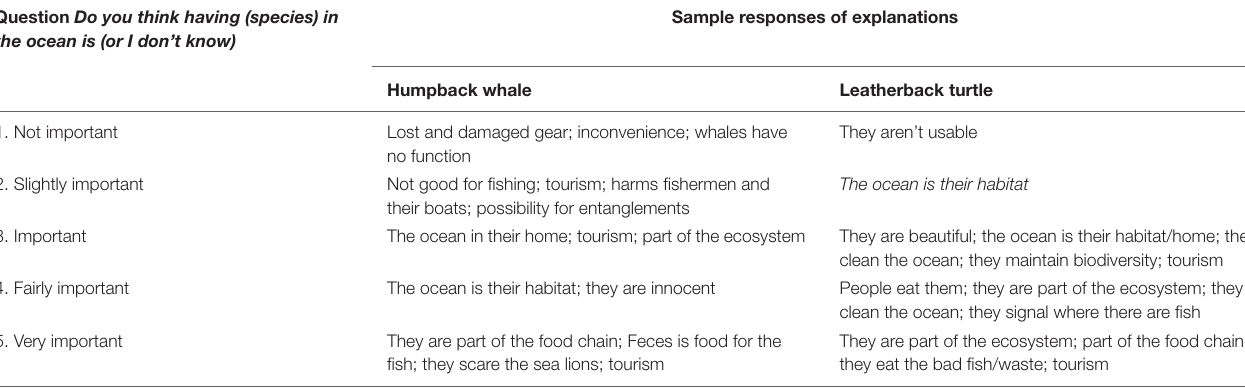
TABLE 4 | Summary of responses to questions 40 and 68 on the perceived importance of species. Question Do you think having (species) in the ocean is (or I don’t know)